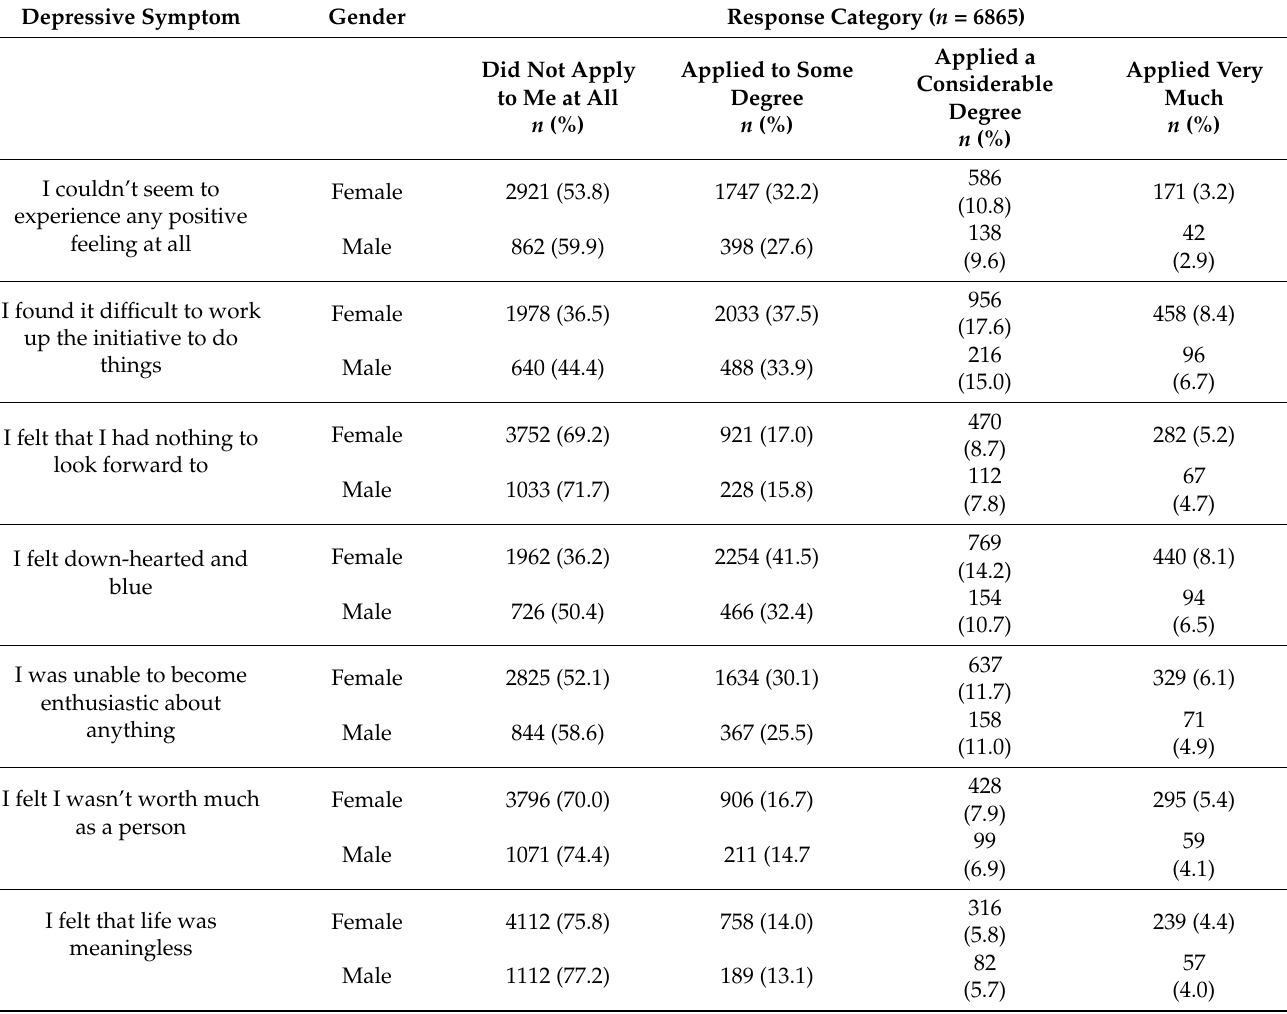
Table 3. Depressive symptoms in men and women in the general population during COVID-19. Depressive Symptom Gender Response Category ( n = 6865)